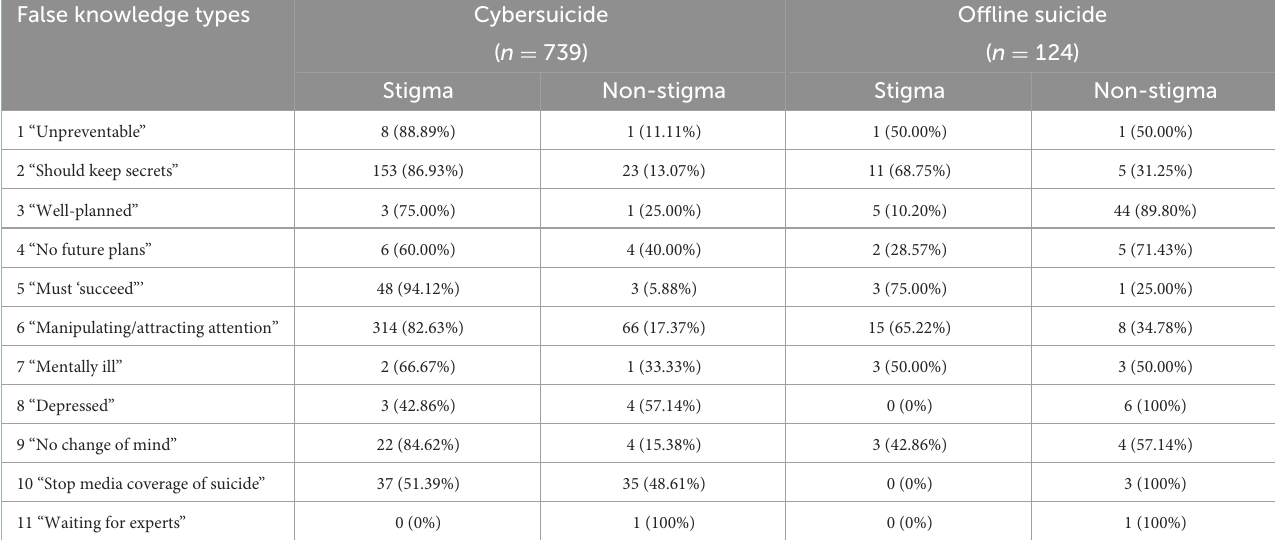
TABLE 2 Proportions of stigmatizing posts across different false knowledge types: n = 863. False knowledge